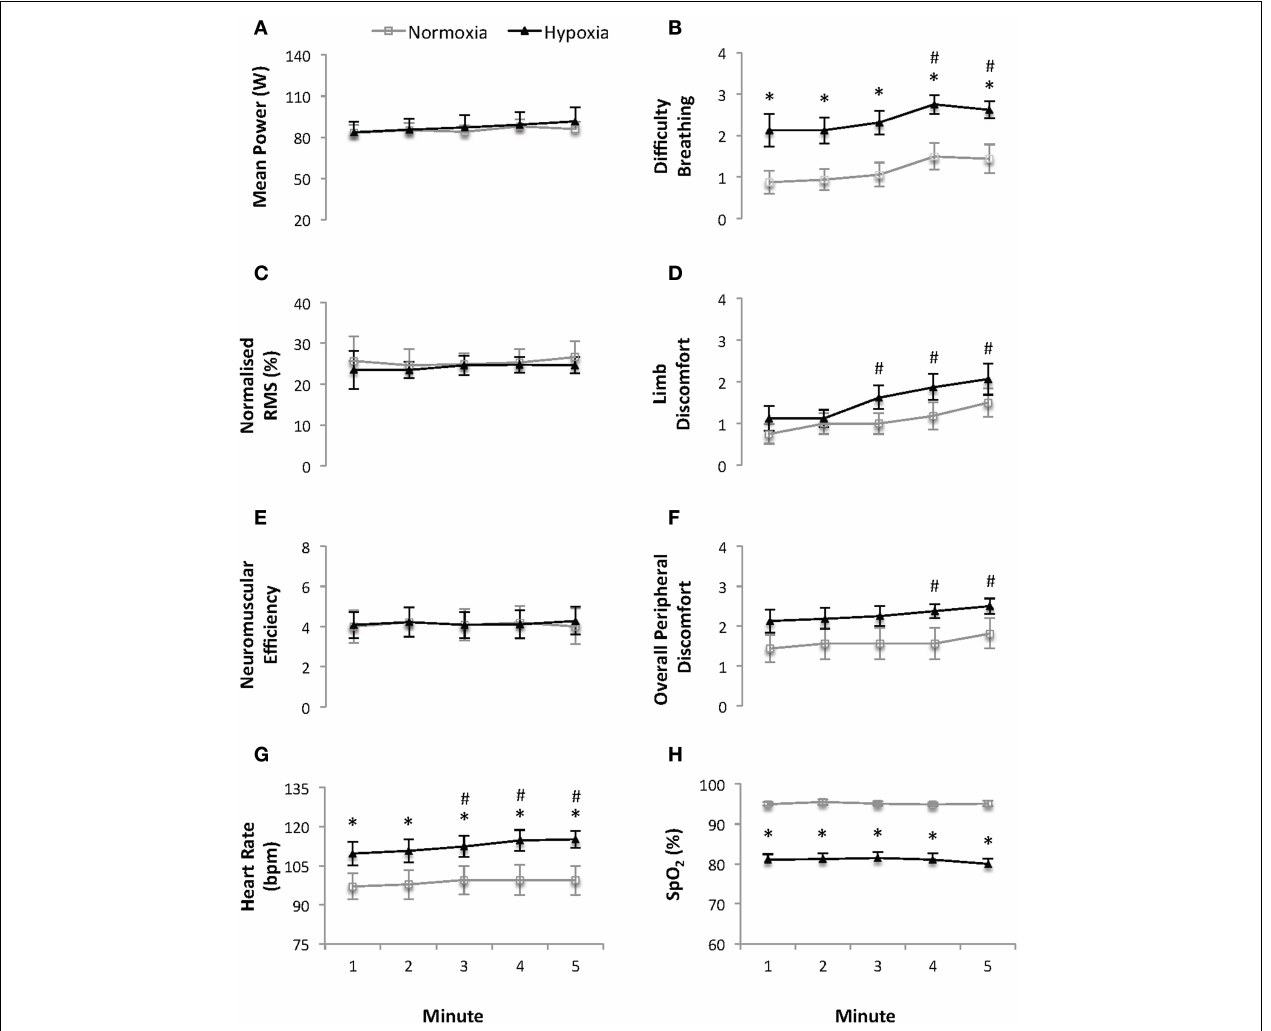
FIGURE 1 | Mean power (W) (A), difficulty breathing (B), normalized quadriceps Root Mean Square (RMS) electromyographical activity (C), limb discomfort (D), neuromuscular efficiency (au) (E), overall peripheral discomfort (F), heart rate (bpm) (G) and arterial oxygen saturation (SpO 2 ) (H) recorded at 1-minute intervals during the